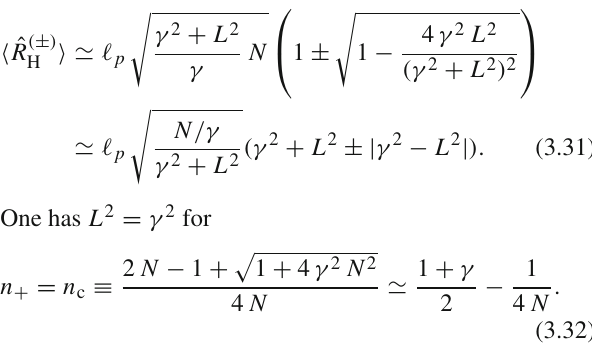
(cid:6) / 2 ( dashed line ) and λ μ = (cid:7) ˆ R ( + ) H